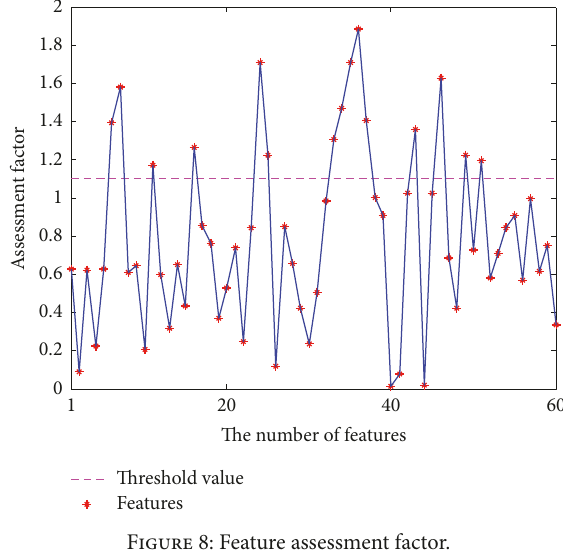
Figure 8: Feature assessment